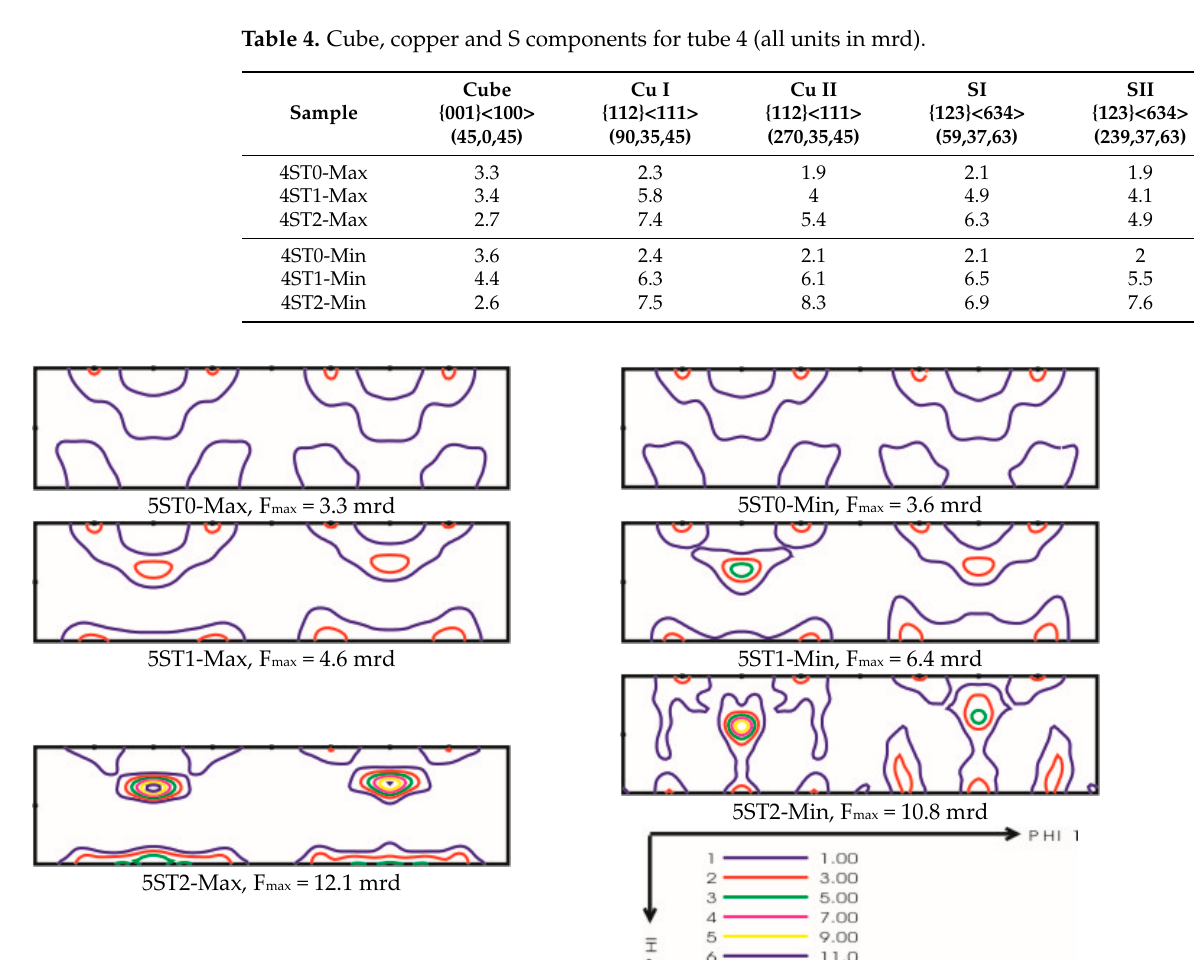
Figure 13. ODF section φ 2 = 45° of tube 5ST after different passes.